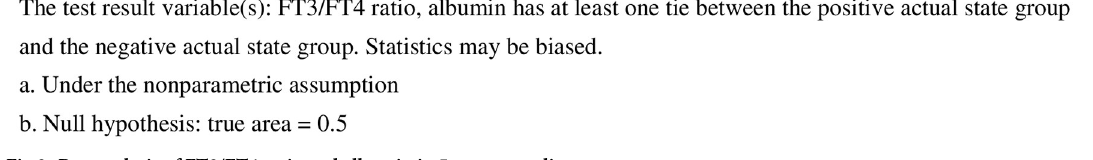
PLOS ONE | https://doi.org/10.1371/journal.pone.0264724 March 14,